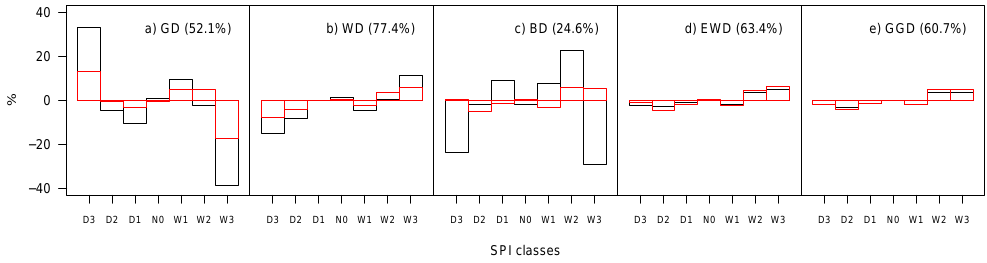
Fig. 8. Differences to the expected probabilities of the SPI classes in percent (CRU data set), using all grid points of the European region (black). SPI time series are calculated with (a) GD, (b) WD, (c) BD, (d) EWD and (e) GGD. The percentages each distribution is approaching AICD ≤ 2 is given in parentheses. Additionally, the differences for SPI time series selected according to this criterion are given (red).